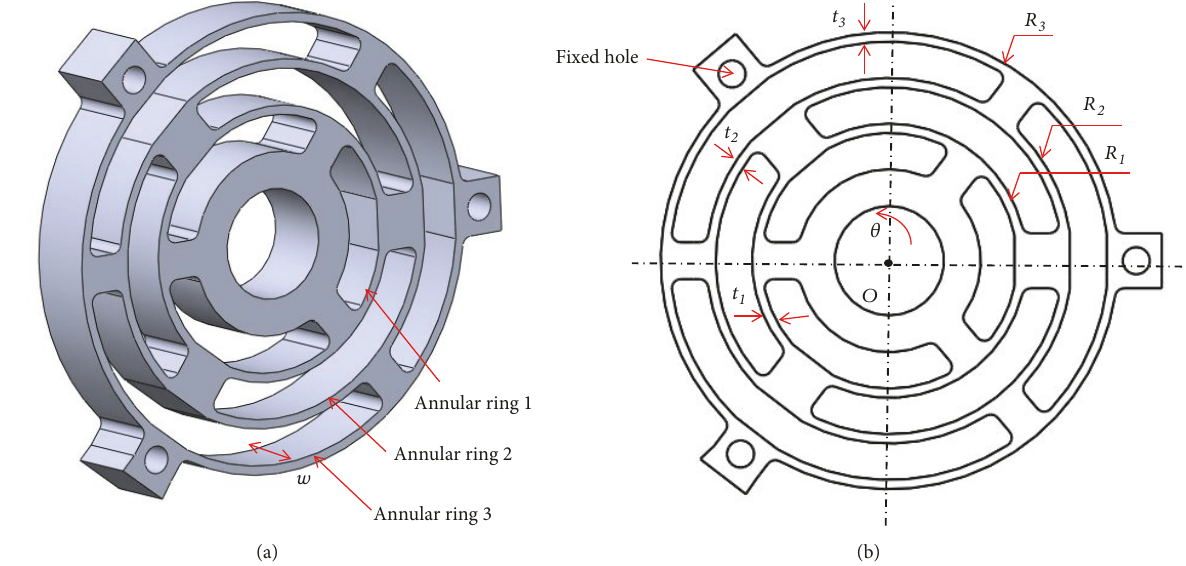
Figure 1: Flexure elbow joint: (a) 3D model; (b) 2D